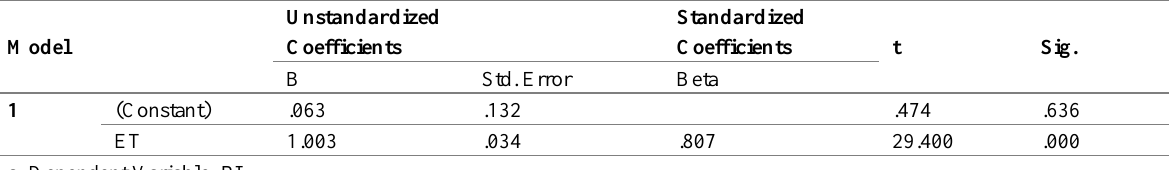
Table 15: Results of Linear Regression between Ethical and Purchase Intention